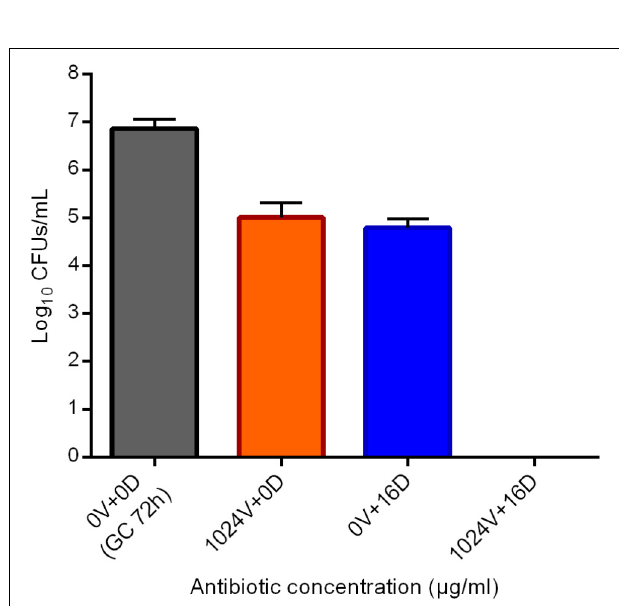
FIGURE 8 | Evaluation of the eradicating activity of the sequential treatment vancomycin/daptomycin against a 24 h-old MRSA biofilm by sonication and colony counting (Log 10 CFUs/mL). Numbers indicate vancomycin (V) and daptomycin (D) concentrations ( µ g/ml). GC 72h; growth control of untreated 72 h-old biofilm. Data are expressed as mean ± SD, n =